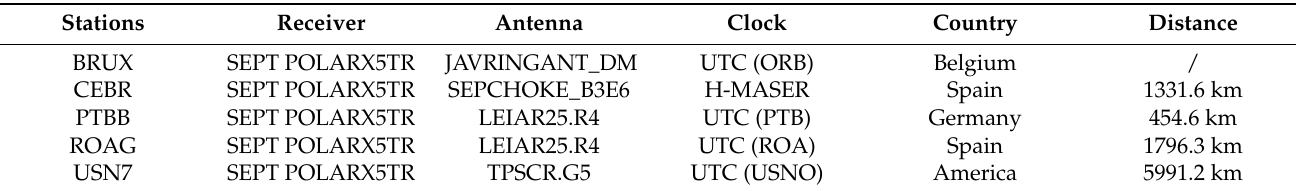
Figure 1. Geographic distribution of the selected stations. Table 2. List of selected MGEX stations.